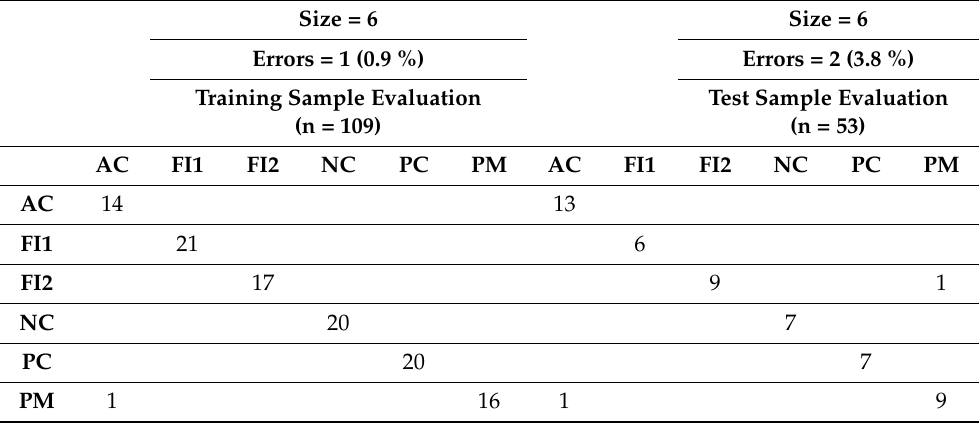
Figure 5. Land use and land cover in Bahia according to TerraClass Cerrado 2013 data, and classification of landscape typologies in the Cerrado of Bahia. ( A ) Land use and land cover map in Bahia in 2013 according to TerraClass Cerrado: LULC map in the state of Bahia according to TerraClass Cerrado 2013 data. ( B ) Natural and anthropic cover map in Bahia in 2020 according to PRODES Cerrado: the map shows the natural cover and all anthropic covers represented by the class anthropic in 2020 according to PRODES Cerrado. ( C ) Landscape types in Bahia: Typology map in the state of Bahia obtained from the decision tree classification. Table 1. Confusion matrix of training samples and test samples used to classify the landscape typology of the Bahia Cerrado